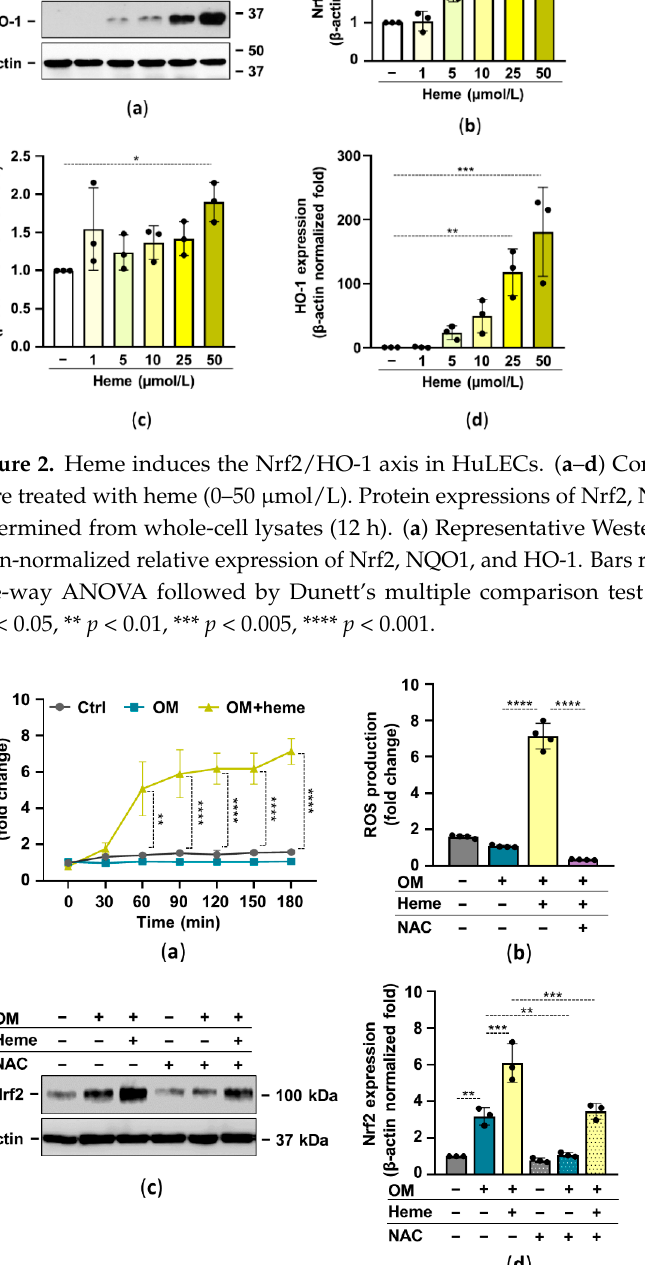
Figure 3. Heme-mediated ROS production plays a role in Nrf2 activation. Confluent HuLECs (passage number 5–8) were treated with OM and OM + heme (25 µmol/L) in the presence or absence of NAC (5 mmol/L). ( a ) Kinetics of intracellular ROS production was monitored for 3 h. ( a , b ) Data points are derived from 4 independent experiments. ( b ) ROS production (3 h), n = 3. ( c , d ) Protein expressions of Nrf2 and β -actin in whole-cell lysates (12 h). ( c ) Representative Western blots (n = 3). ( d ) β -actin-normalized Nrf2 expression. Data are expressed as mean ± SD. Ordinary one-way ANOVA followed by Tukey’s multiple comparison test was used to obtain p values. ** p < 0.01, *** p < 0.005, **** p < 0.001.